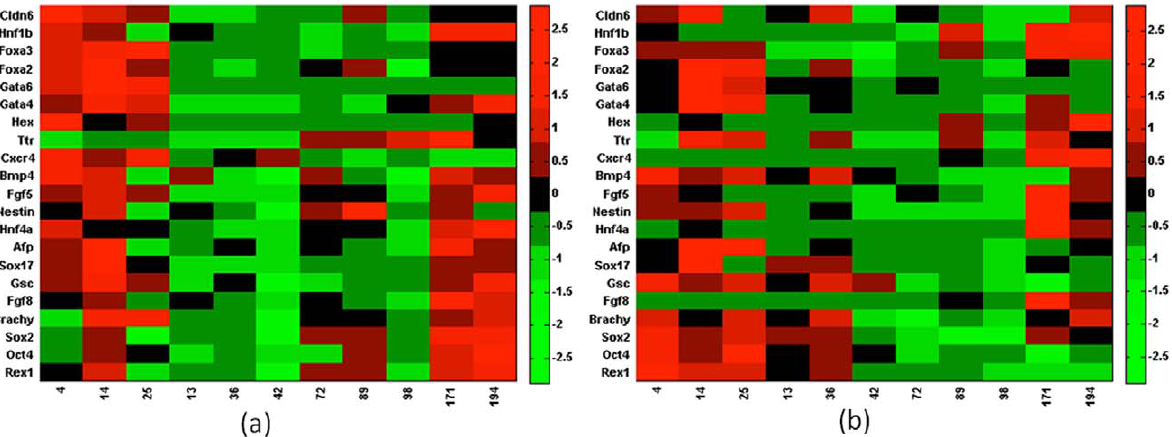
Figure 2. Effect of substrate stiffness on differentiation of embryonic stem cell to early germ layers . Embryonic stem cells were differentiated on fibrin substrates of varying stiffness and subsequently analyzed for early germ layer markers. In the above figure x-axis represents the storage modulus of the synthesized fibrin gel (Pa); the y-axis represents germ layer specific markers. Endoderm germ layer was analyzed in more detail since the initial observation revealed the endoderm to be most responsive to changes in the substrate properties. Experiments were conducted under 2 different culture configurations: 2-dimentional (Figure 2a) and 3-dimentional (Figure 2b). The data was normalized by mean centering and variance scaling.